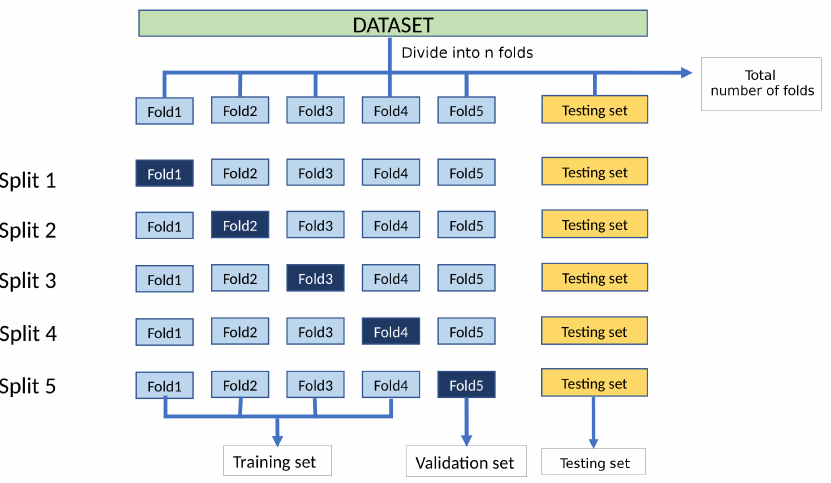
Figure 9. Stratified five-folds cross-validation, leaving one out for validation and the remaining 4 folds are used for training. Dark blue representing validation folds, light blue colour folds are used as training set and yellow colour folds are used as testing set containing unprocessed images. This generates 5 trained models.